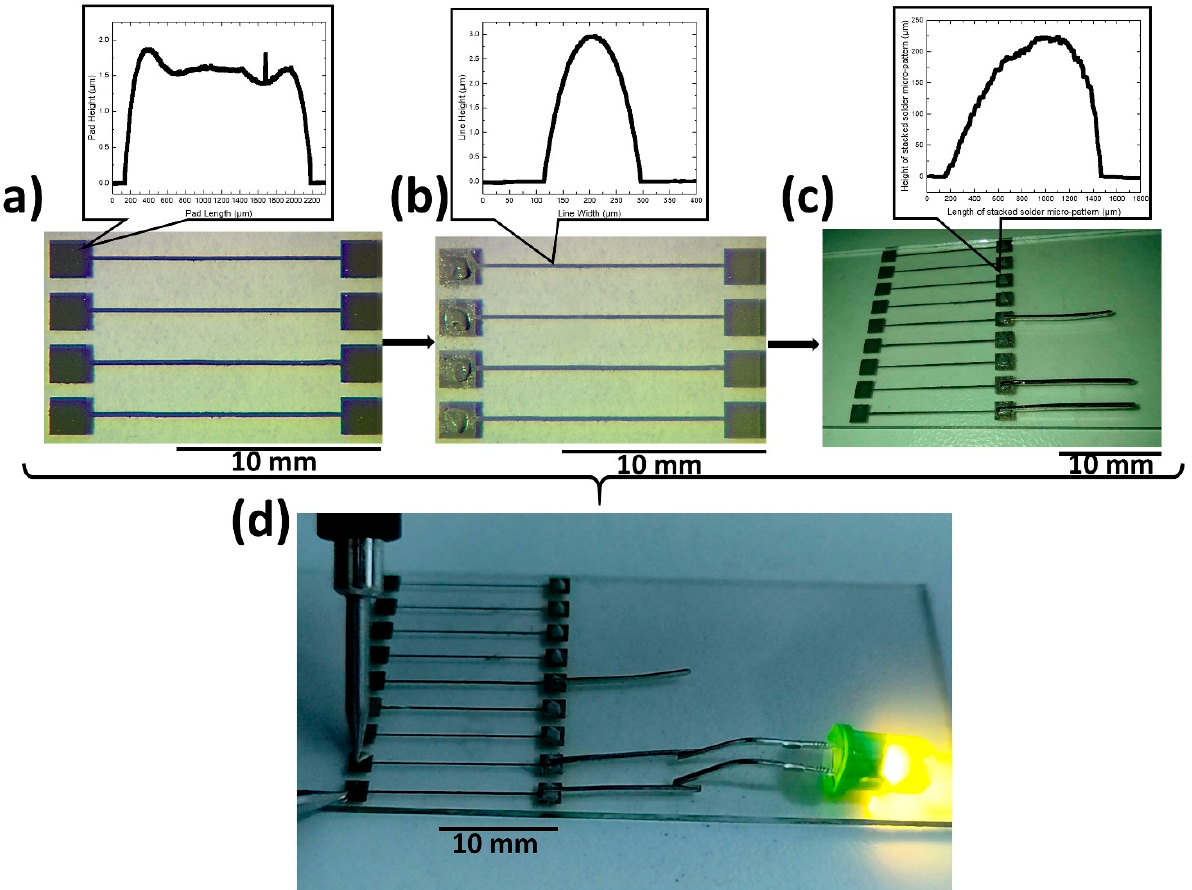
Figure 8. ( a ) Image of laser-printed and sintered linear patterns each connected to their respective pads; ( b ) Image of laser- printed solder paste stacked micropatterns on pads; ( c ) Image of the deposited pin connectors on the solder micropatterns prior to thermal treatment; Insets: Profilometry measurements of the LIFT printed and sintered pad (top left) and linear pattern (top middle) and of the LIFT printed solder paste micro-pattern (top right); ( d ) Operating a commercial LED by applying 3 V on LIFT printed and laser sintered silver pads.